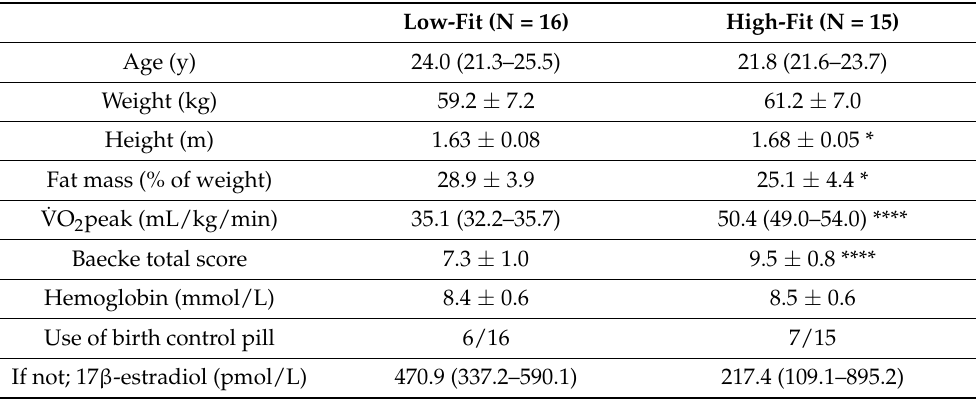
Table 1. Subject